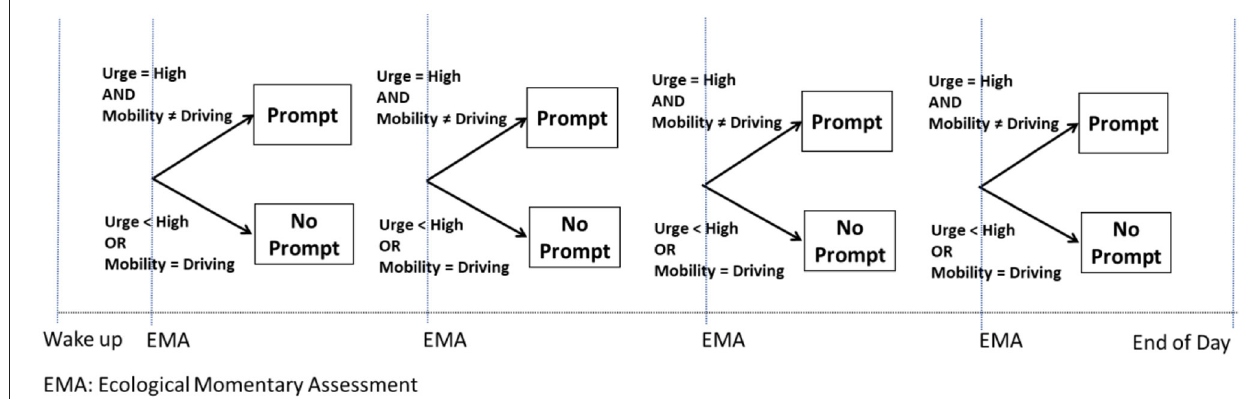
FIGURE 4 | Hypothetical just in time adaptive intervention (Example D).